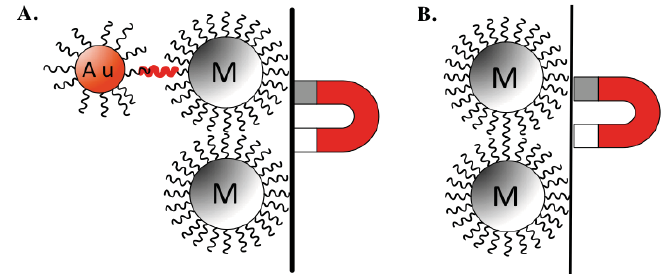
Figure 1. Schematic of AuNP-DNAt-MNP sandwich structure. ( A ) The presence of specific DNAt (red wavy bar) will covalently bind with DNAt specific probes (black wavy lines) on AuNP (red Au labeled bead) and the MNP (grey M labeled bead), allowing the collection of AuNP. ( B ) Absence of specific DNAt will lead to the failure of AuNP collection (image used with permission from Michael J. Anderson at Michigan State University,